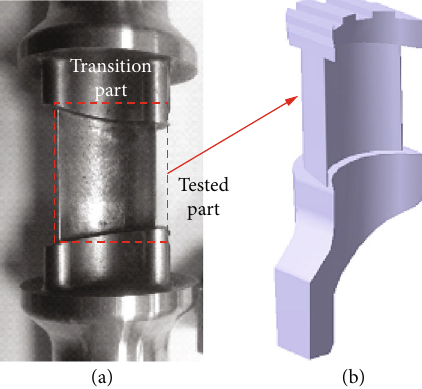
Figure 11: Blade model and the